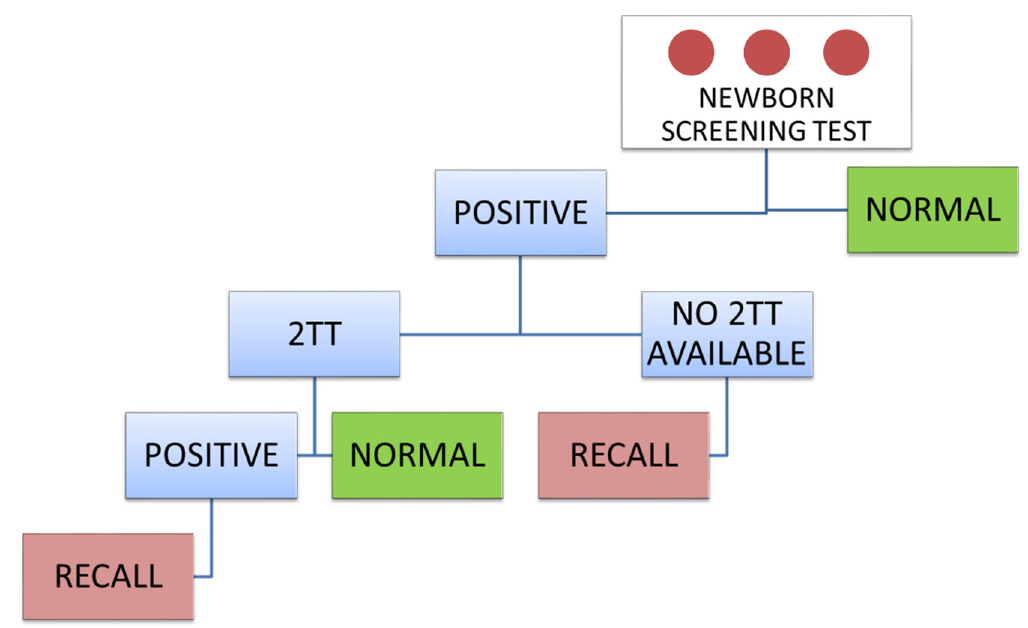
Figure 1. Flow-chart for newborn screening analytical process. When a 2-TT is available, the specificity of newborn screening is significantly improved. It may also be possible to reduce primary test cut-off to improve sensitivity.